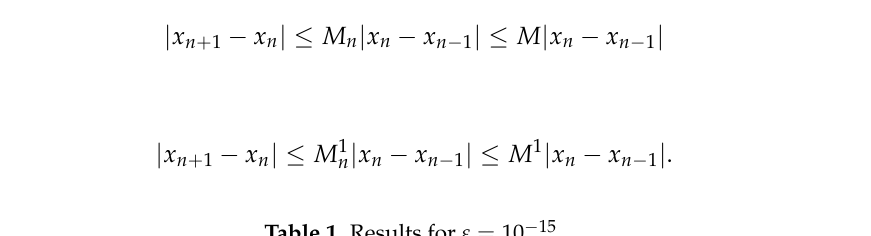
Table 1. Results for ε = 10 − 15